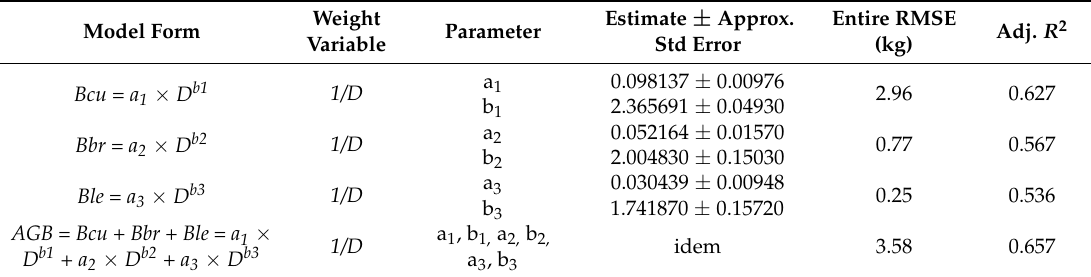
Table 5. SUR method estimating parameters of simple model combination with single variable D of bamboo biomass components using the entire dataset.